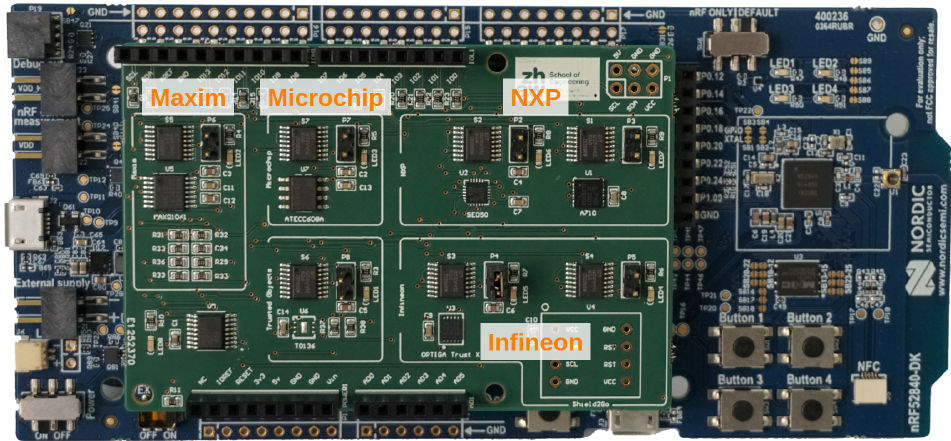
Figure 4. Secure node consisting of nRF52840 DK and secure element